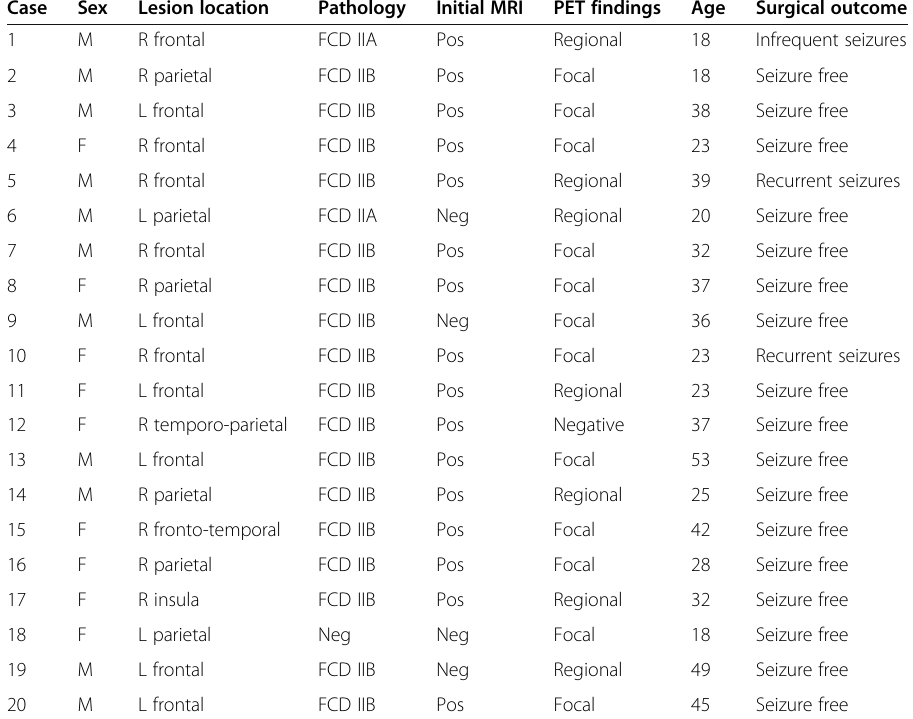
Table 1 Patient clinical data